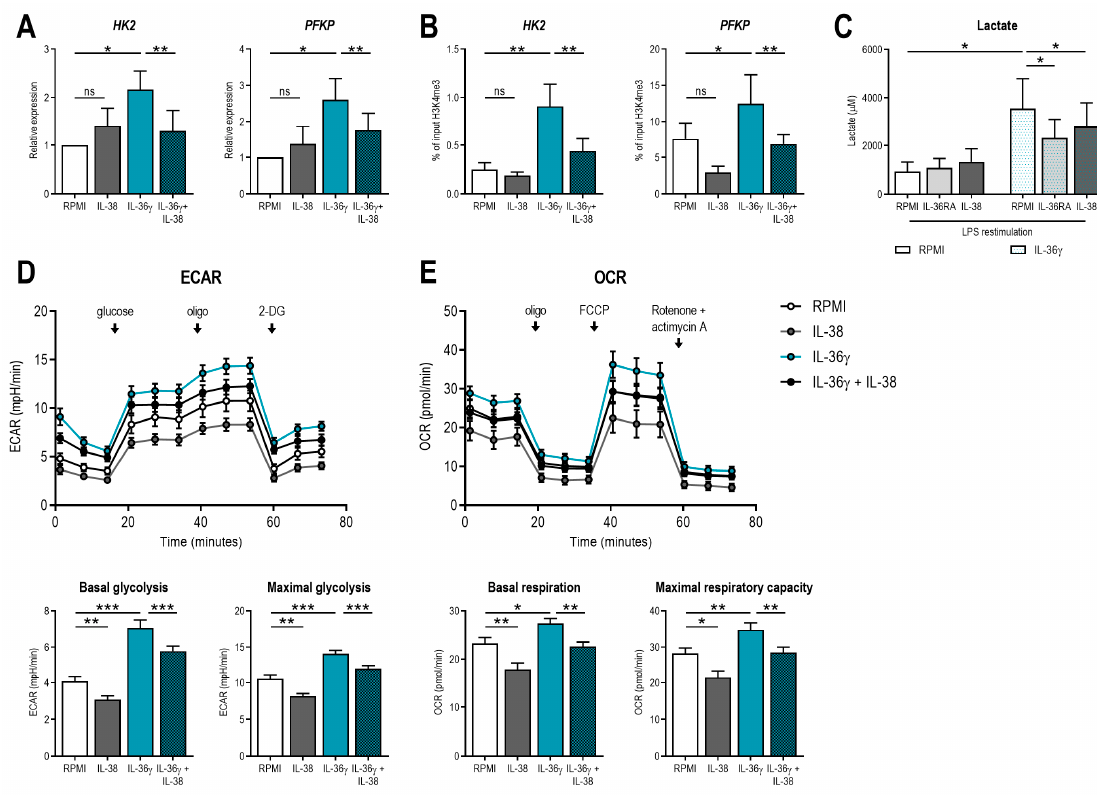
Figure 3. IL-36 γ induces immunometabolic changes in human monocytes. ( A ) Human monocytes were incubated for 24 h with 50 ng/mL of IL-36 γ with or without 90 ng/mL IL-38. After five days of rest in medium, cells were restimulated with 10 ng/mL LPS, and expression of HK and PFKP was determined after 4 h. ( B ) Human monocytes were incubated for 24 h with 50 ng/mL of IL-36 γ with or without 90 ng/mL IL-38. After five days of rest in medium, cells were fixed, and the percentage of H3K4me3 at the promoters of HK and PFKP was determined. ( C ) Human monocytes were incubated for 24 h with 50 ng/mL of IL-36 γ with or without 90 ng/mL IL-38. After five days of rest in medium, cells were restimulated with 10 ng/mL LPS for 24 h, and lactate concentration was determined in supernatants. ( D , E ) Human monocytes were incubated for 24 h with 50 ng/mL of IL-36 γ with or without 90 ng/mL IL-38. After five days of rest in medium, extracellular acidification rate (ECAR) ( D ) and oxygen consumption rate (OCR) ( E ) were determined by Seahorse in a glycolysis and mito stress test, respectively. (Mean ± SEM, n = 6, Wilcoxon signed-rank test, ns = non-significant, * p < 0.05, ** p < 0.01, *** p < 0.001.) To further assess the mechanisms through which IL-36 γ induces trained immunity, we investigated downstream signaling pathways associated with the induction of innate immune memory. It has been shown previously that mTOR is one of the central regulatory molecules in the induction of trained immunity [7,15]. IL-36 γ is known to signal via MyD88, MAP kinases, and NF- κ B [8], and IL-38 is able to inhibit MAP kinases and also mTOR signaling [7,16]. Here, we now also show that IL-36 γ induces mTOR activation which can be inhibited by the addition of IL-38 (Figure 4A). In order to expand this view on essential signaling molecules in the induction of trained immunity, we next focused on NF- κ B. Firstly, human monocytes were pre-incubated for 1 h with IL-38, before IL-36 γ was added to the medium. After 10 min, cells were lysed, and phosphorylation of NF- κ B was determined by Western blot. IL-36 γ increased p65 phosphorylation of the NF- κ B complex, and pre-incubation with IL-38 abrogated this effect (Figure 4B). To determine